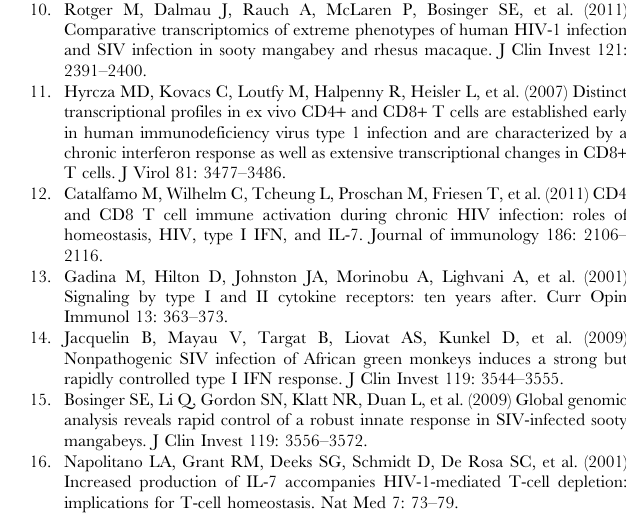
Figure S7 Phenotype of donor T cells in lymphopenic mice chronically treated with IFN- a . Thirty-five days after transfer, expression of CD44, CD62L and CD25 on CD4 + and CD8 + donor T cells was assessed in LNs and spleen of mice from the groups described in Figure 7. ( a ) Gating strategy to assess the proportion of naı¨ve (Tn: CD44 low CD62L high ), central memory (Tcm: CD44 high CD62L high ), effector memory (Tem: CD44 high CD62L low CD25 2 ) and effector (Teff: CD44 high CD62L low CD25 + ) on gated CD45.2 + CD3 + CD4 + and CD8 + lymphocytes in control and IFN- a treated animals ( b ) The percentages of naı¨ve, central memory, effector memory and effector on gated CD45.2 + CD3 + CD4 + and CD8 + lymphocytes in control (open symbol) and IFN- a treated (black symbols) animals are indicated and presented as median. ( c ) Absolute numbers of donor T cell subsets in the lymphoid organs were enumerated following the treatment with rmIFN- a (black symbols) and PBS (open symbols). A nonpara- metric Mann-Whitney test was performed for comparisons between groups. Data from two representative experiments out of four, including an average of 4 mice per group, are presented. Table S1 Viral Infection history from HIV-infected patients described in Figure 1 and Figure